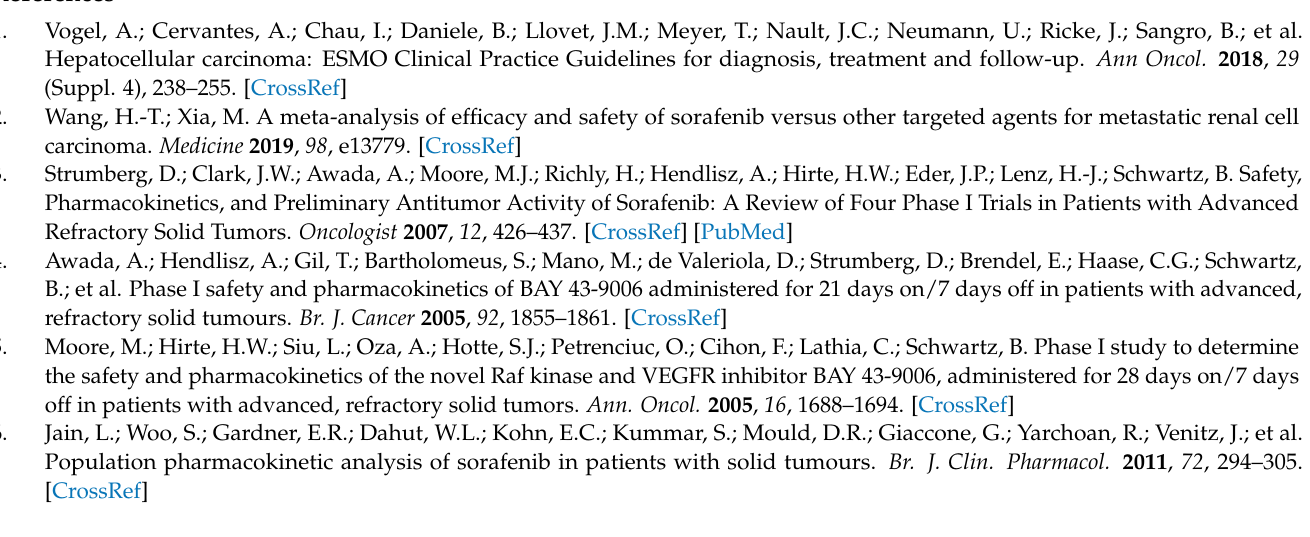
Table S2: Summary of physiological and molecular characteristic considered in regression analyses. Table S3: Logistic regression analysis of therapeutic C max threshold of >5.5926